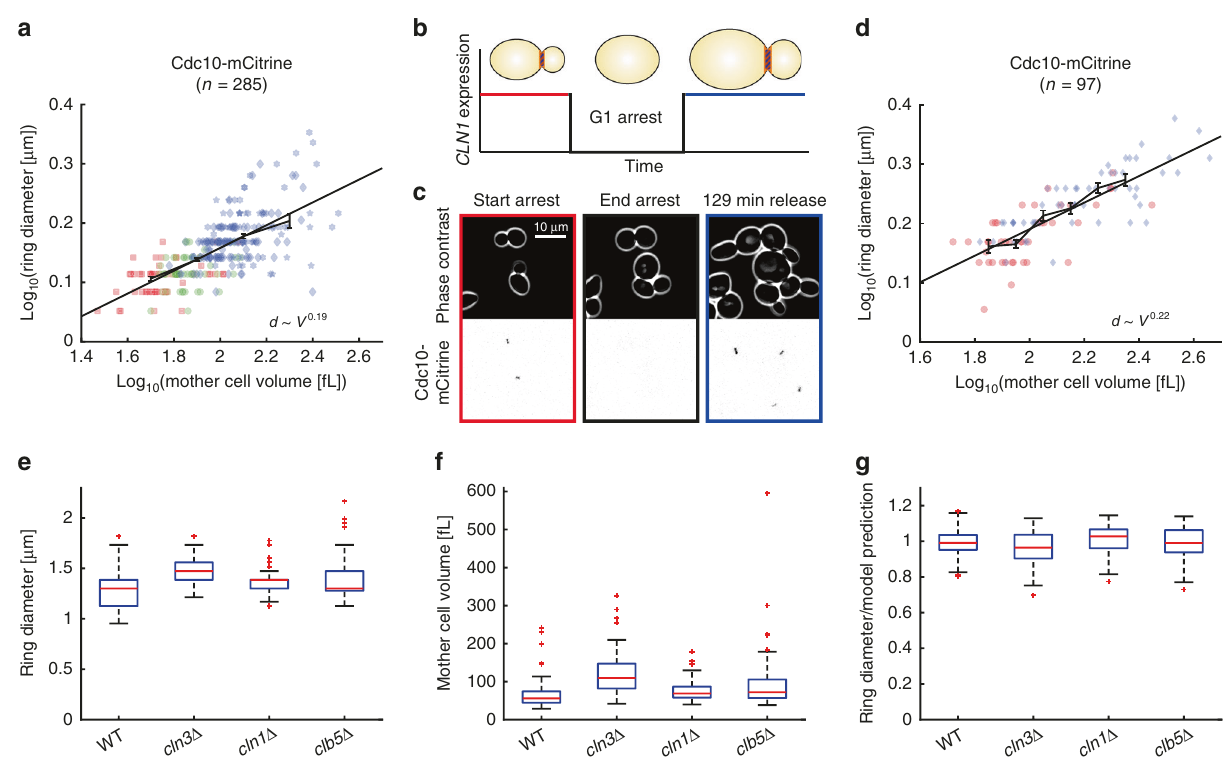
Fig. 3 Ring diameter increases with cell volume for cells grown in SCD and is not sensitive to CDK activity. a Septin ring diameter based on Cdc10- mCitrine fl uorescence as a function of cell volume. Cell volume was controlled through β -estradiol-dependent expression of Whi5 (red squares: 0 nM; green circles: wild type; blue: 60 nM (diamonds), 90 nM (pentagrams), 120 nM (hexagrams)). For each cell, the median ring diameter during the time when the ring is detected is shown as a function of the median cell volume during that time. Data from different conditions are pooled (285 cells from fi ve independent experiments) and a linear fi t to the double-logarithmic data as well as binned means with standard error is shown. b A cln1/2/3 Δ strain carrying a β -estradiol-inducible CLN1 allele and CDC10-mCitrine was used to measure septin ring diameter as a function of cell volume. Ring diameter was measured for cells growing in the presence of β -estradiol, or cells released from G1 arrest after 2.5 h of β -estradiol withdrawal. c Representative live-cell microscopy images (phase contrast (top) and mCitrine fl uorescence (bottom)). d For each cell, the median ring diameter is shown as a function of the median cell volume. Pre-arrest (red circles) and post-G1-arrest data (blue diamonds) were pooled (97 cells from three independent experiments), and a linear fi t to the double-logarithmic data as well as binned means with standard errors is shown. Cells were grown on SCD. e – g Cell volume and septin ring diameter based on Cdc10-mCitrine fl uorescence were measured in haploid cyclin deletion mutants cln3 Δ (64 cells pooled from two independent experiments), cln1 Δ (97 cells pooled from two independent experiments), and clb5 Δ (52 cells pooled from two independent experiments) and compared with wild-type haploids (106 cells pooled from three independent experiments). Boxplots show distributions of median septin ring diameters ( e ) and median cell volume ( f ). g For each cell, we compare the measured ring diameter to the value expected for wild-type cells with the same mother cell volume based on the power law fi t obtained for wild-type and inducible-Whi5 cells shown in Fig. 2c. Boxplots depict the distribution of the ratios of measured and expected ring diameters. Cells were grown on SCGE. Boxplots depict medians, 25 and 75 percentiles. Whiskers denote extreme values still within 1.5 interquartile ranges, red symbols denote outliers. Source data are provided as a Source Data fi